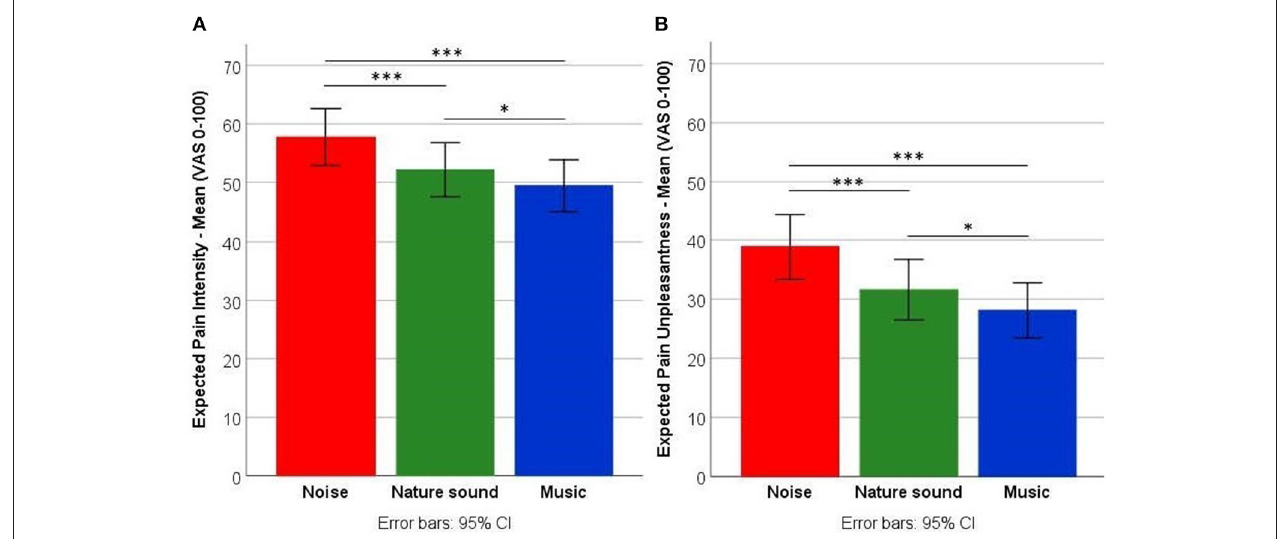
FIGURE 3 | Expected pain levels. Comparisons of noise, nature sound, and music on (A) expected pain intensity and (B) expected pain unpleasantness (regardless of pharmacological manipulations). * p < 0.05; *** p < 0.001.